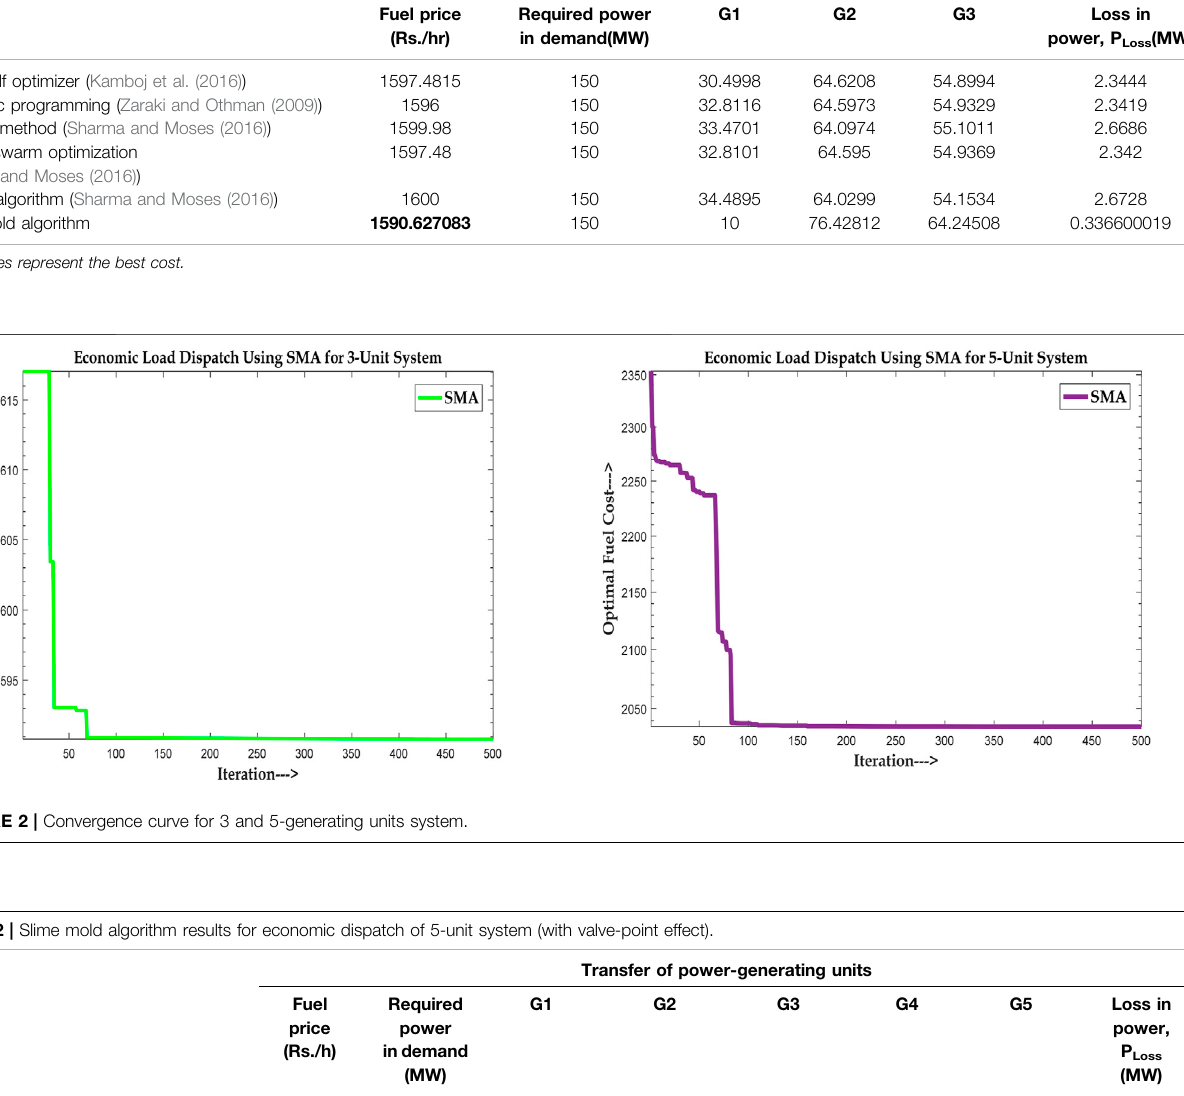
TABLE 1 | (Case I) Slime mold algorithm results for economic dispatch of 3-unit system (without valve-point effect). Method